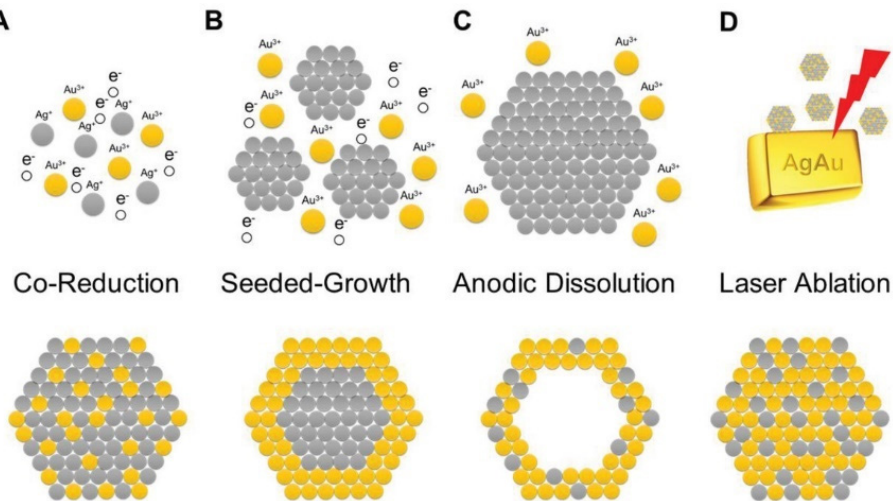
Figure 4. Schematic representations of the synthesis of alloyed bimetallic nanoparticles considering the silver-gold system. ( A ) Bottom-up synthesis, leading to alloyed silver-gold nanoparticles after co-reduction. ( B ) Bottom-up synthesis, leading to silver-gold core-shell nanoparticles (seeded-growth approach). ( C ) Bottom-up synthesis, leading to hollow gold nanoshells (anodic dissolution of the silver core). ( D ) Top-down synthesis to prepare alloyed silver-gold nanoparticles starting from a bimetallic alloy by laser ablation. Reprinted with permission from [57]. Copyright 2020, Wiley.